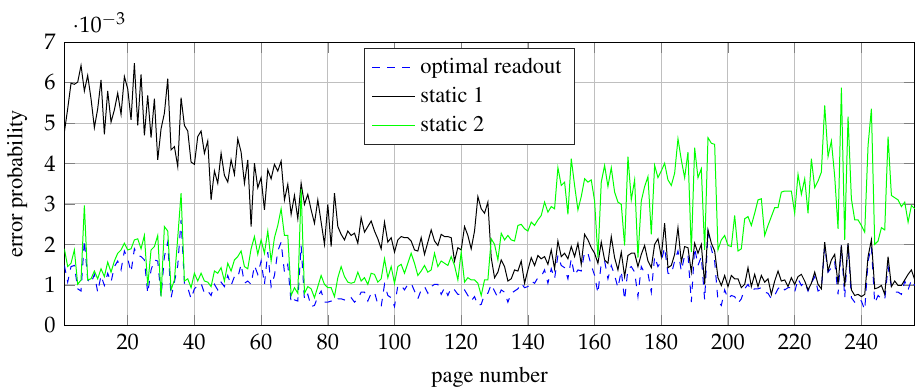
Figure 11. Error probability of a TLC block on r 7 (55 h bake, 3000 P/E) for optimal readout and 2 worst case static readouts.